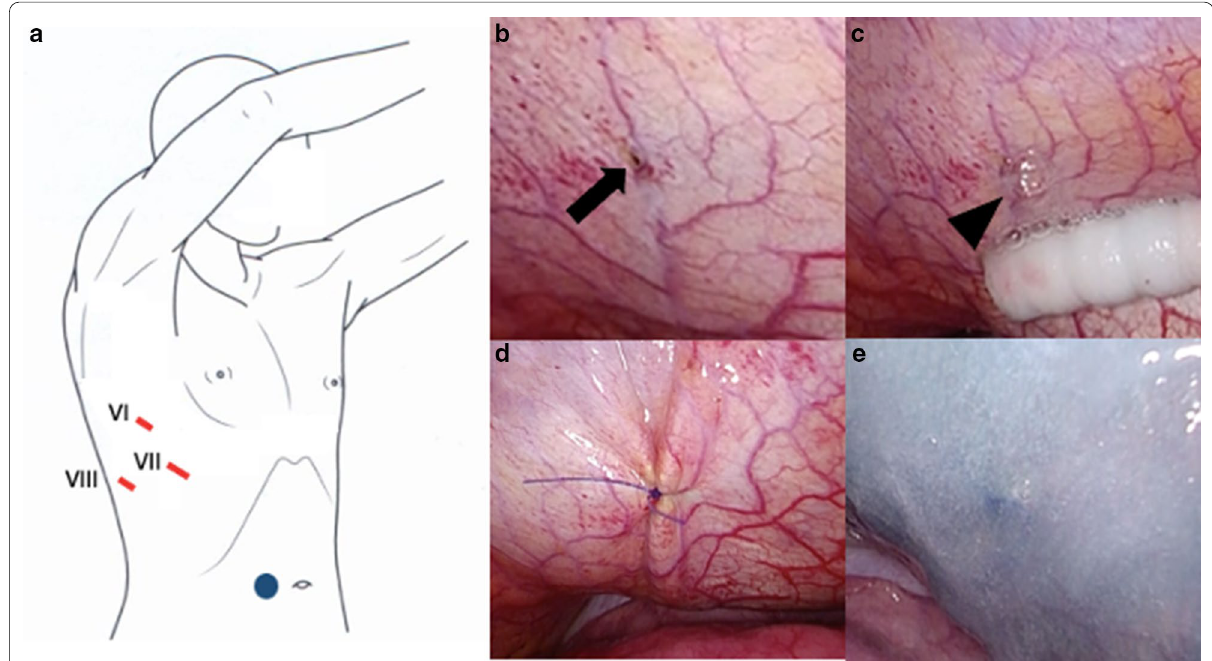
Fig. 2 Diagram of the surgery and surgical view. a VATS in the left-sided half-lateral decubitus position; one skin incision was made to the right side of the navel, and a laparoscope was inserted into this port (blue round). b A thinned diaphragm was detected at the central tendon of the diaphragm (arrow). c Bubbles were observed at this small pore after pneumoperitoneum (arrowhead). d The small pore was closed with 4-0 non-absorbable monofilament sutures. e The central tendon around the reinforcement was covered with a sheet of absorbable polyglycolic acid felt and sprayed with fibrin glue